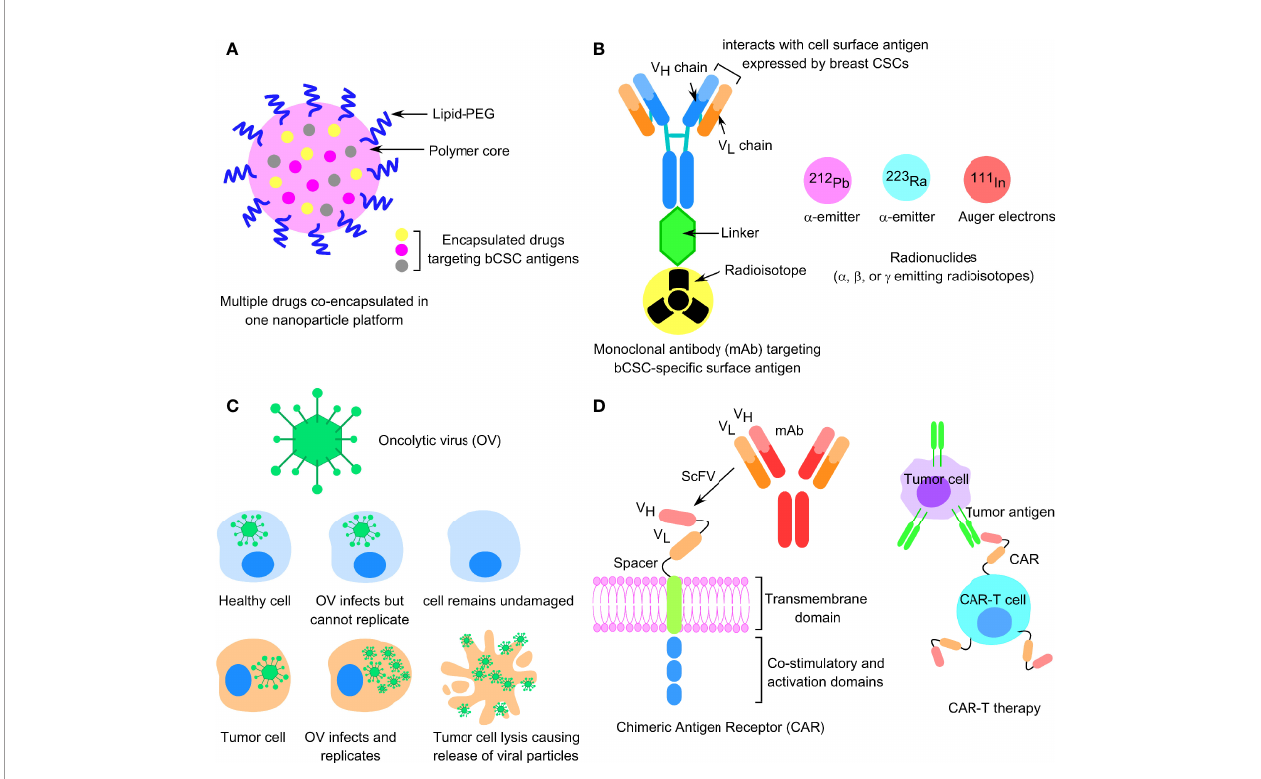
FIGURE 5 | Novel upcoming strategies to reverse bCSC drug resistance. (A) Cartoon structure of a nanoparticle-based drug carrier encapsulated with multiple chemotherapeutic drugs targeting bCSC antigens. (B) a - or b -emitting radionuclide conjugated with monoclonal antibody targeting breast CSC-speci fi c antigens. (C) Design of oncolytic viral particles targeting tumor cells. (D) Cartoon representation of chimeric antigen receptor (CAR-T therapy) against CSC surface